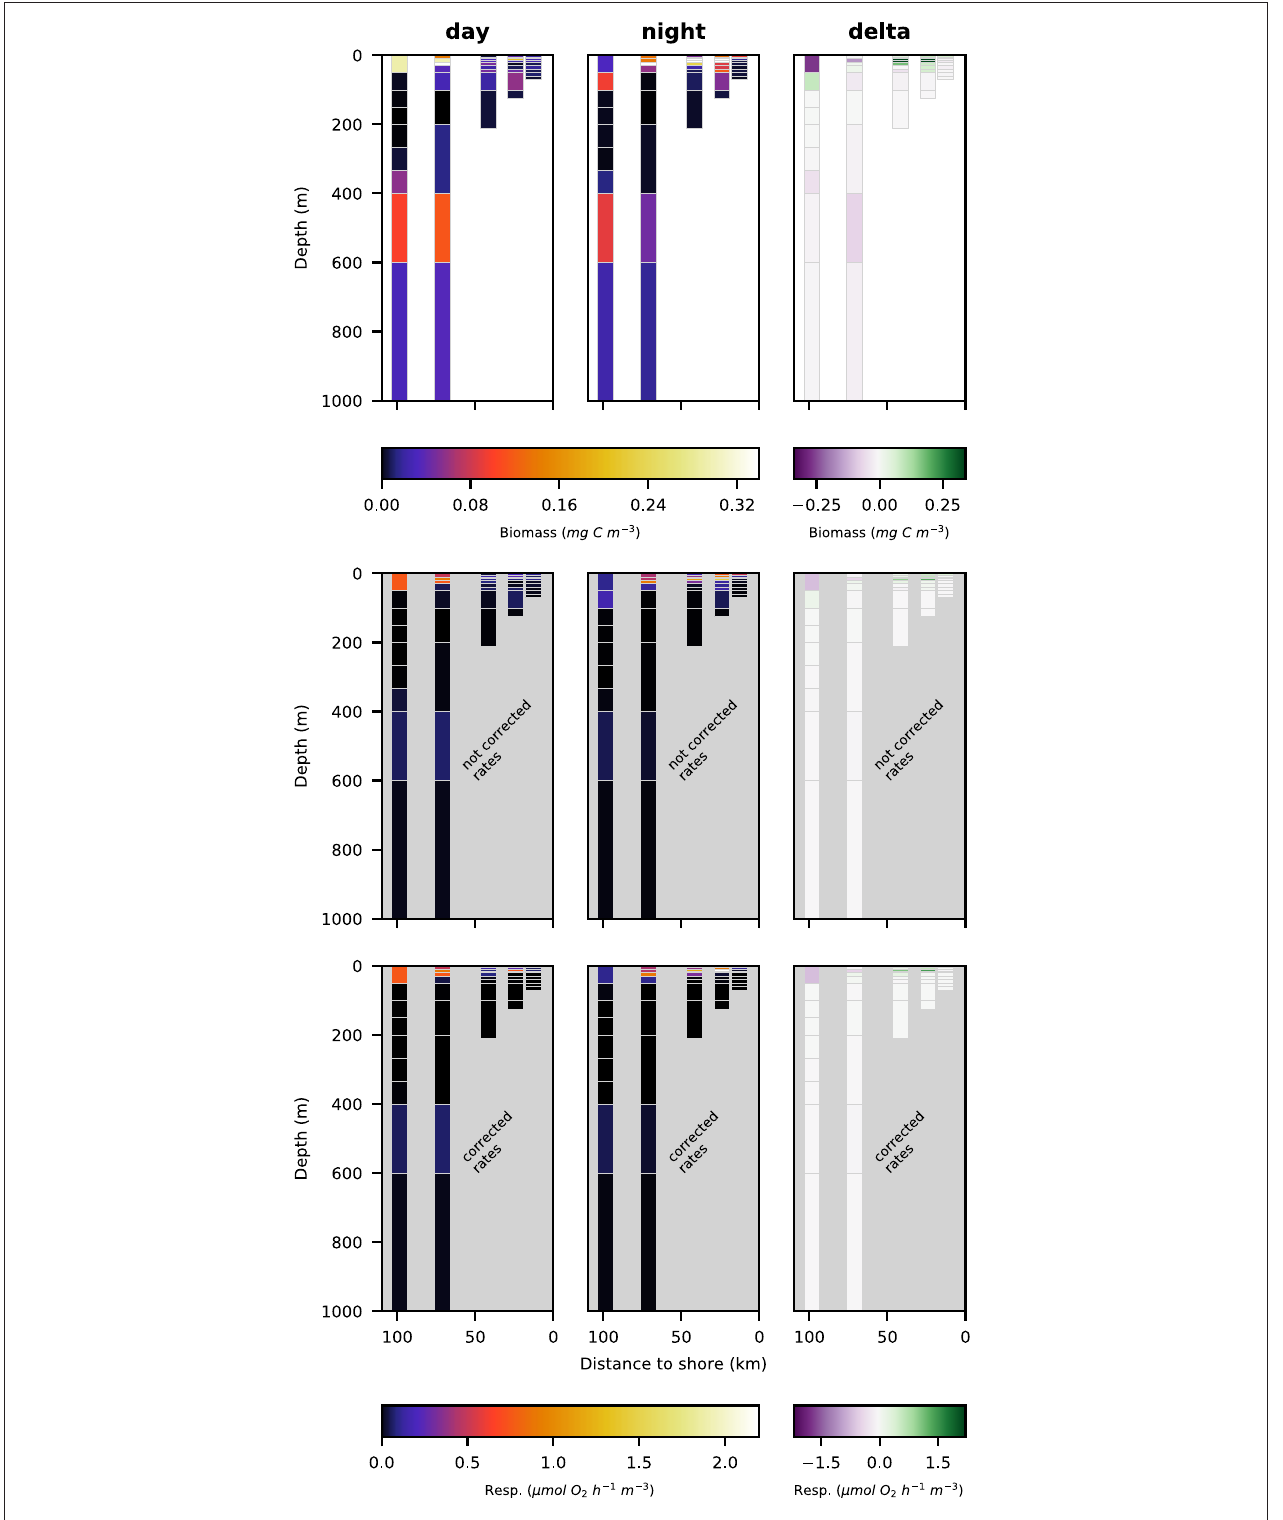
FIGURE 6 | Vertical distribution of copepoda biomass (top row; mg C m − 3 ), not corrected respiration rates (middle row; µ mol O 2 h − 1 m − 3 ) and corrected respiration rates (bottom row; µ mol O 2 h − 1 m − 3 ) along the transect at day (left panels), night (middle panels), and the difference of the two (right panels).